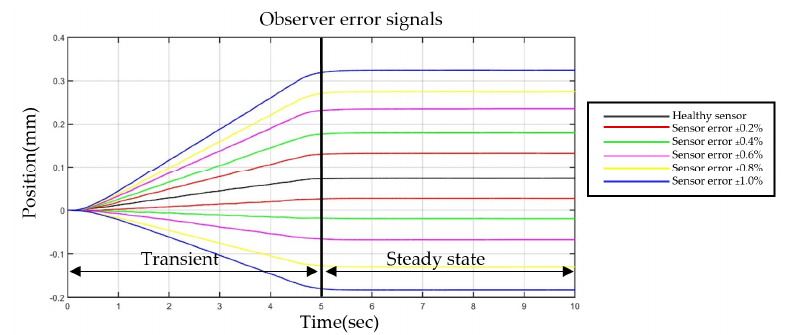
Figure 19. The observer error response.